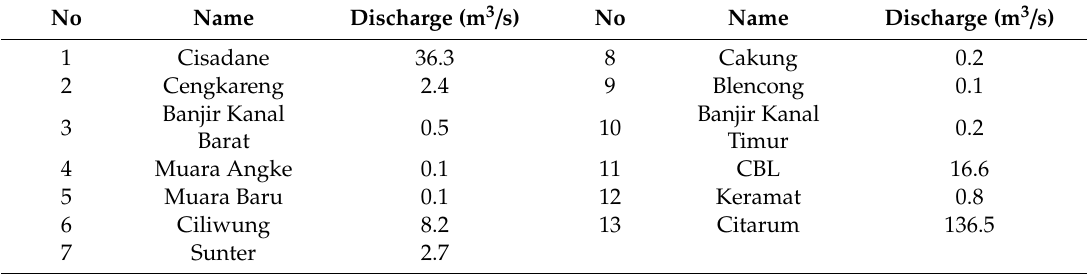
Table 1. River discharge in Jakarta Bay based on Wulp et al. (2016) [28]. For rivers location see Figure